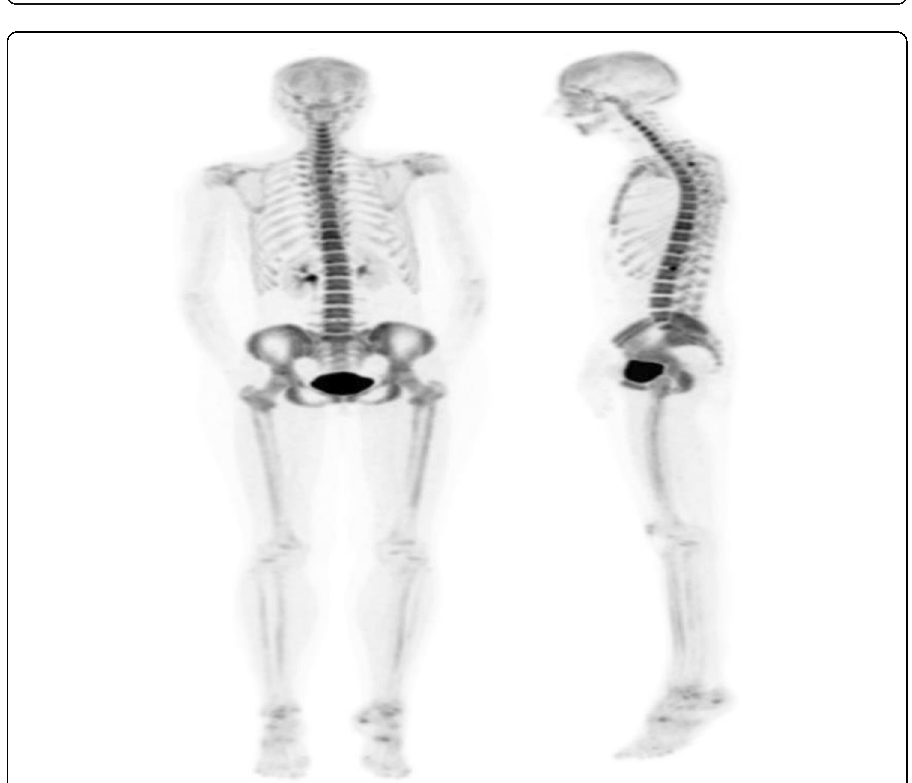
Fig. 69 Physiological biodistribution of 18